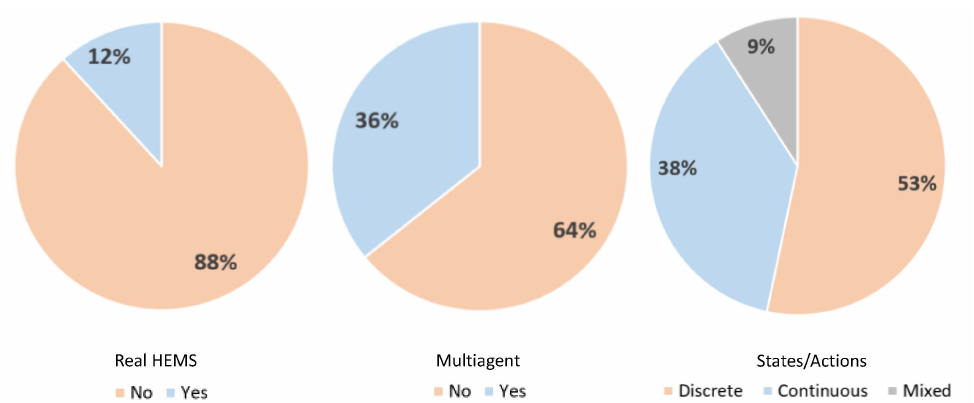
Figure 16. Real-World, Multi-Agents, and Discretization. Proportions of articles deployed in real world HEMS ( left ), using multi-agents ( middle ), and whether the states/actions are discrete or continuous ( right